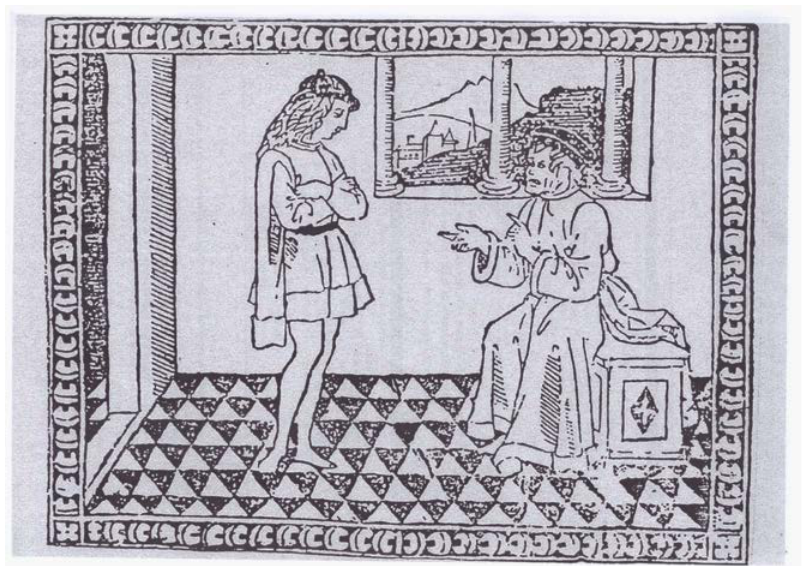
Figure 26 – Antonia Pulci, Rappresentazione del Figliuol prodigo , s.n.t., f. a2r (BNCF, Pal.